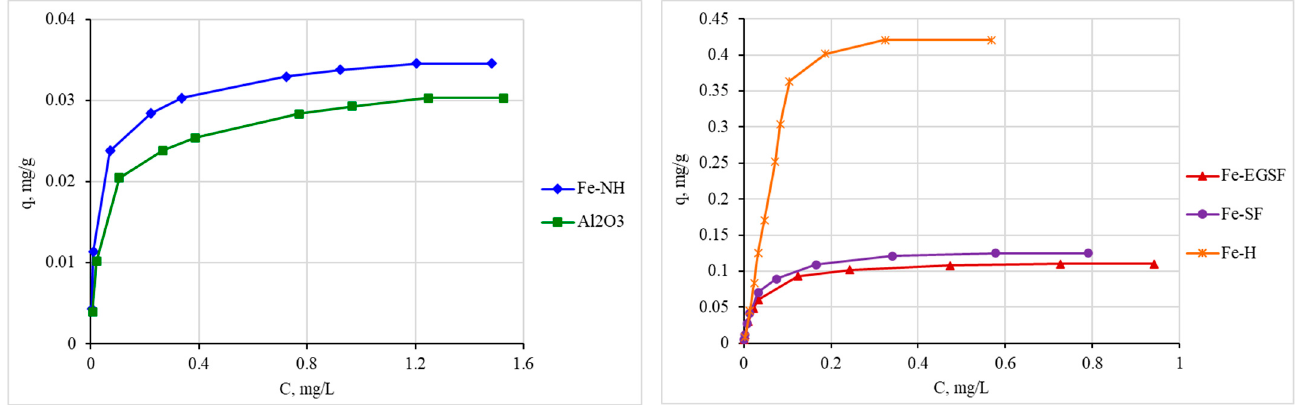
Figure 2. Phosphorus sorption isotherms.